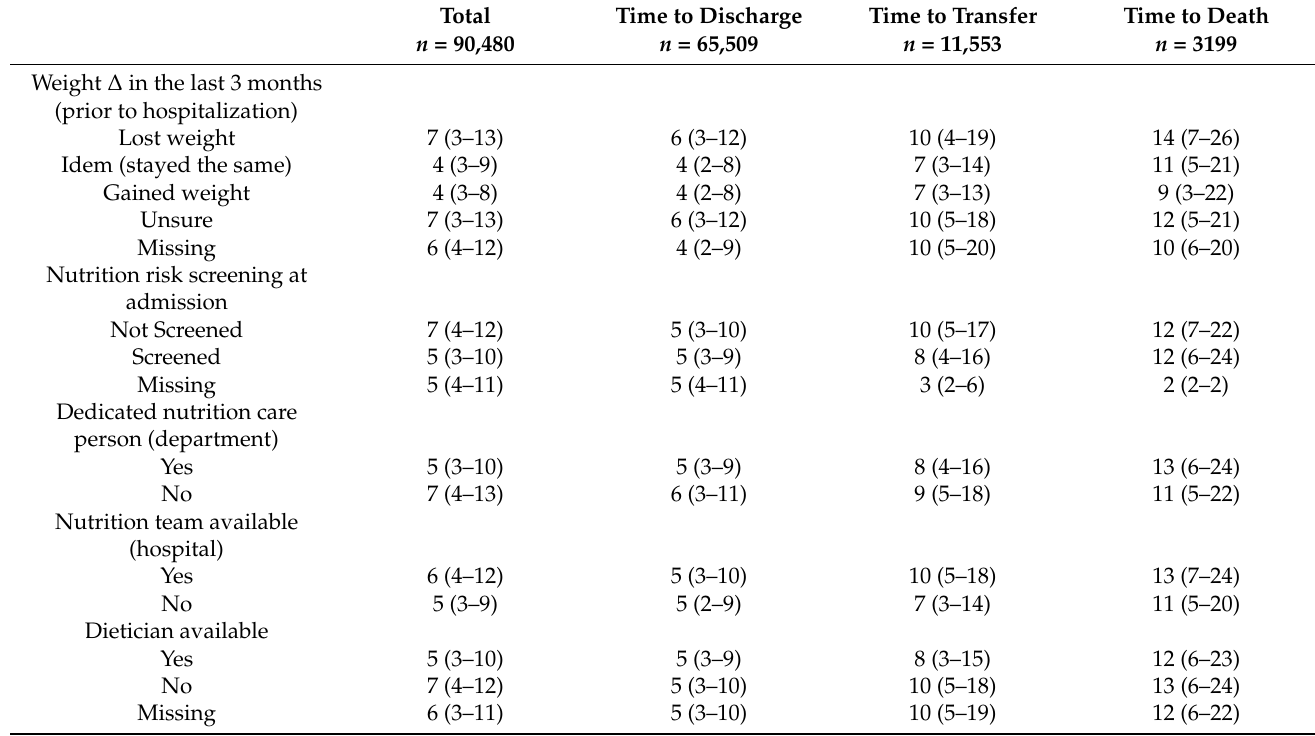
Table 1. Median length of stay by selected * nutrition-related baseline variables adjusted for length